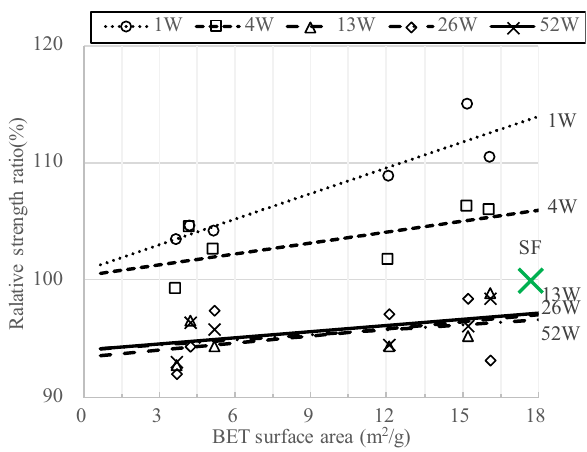
Fig. 18 Strength development